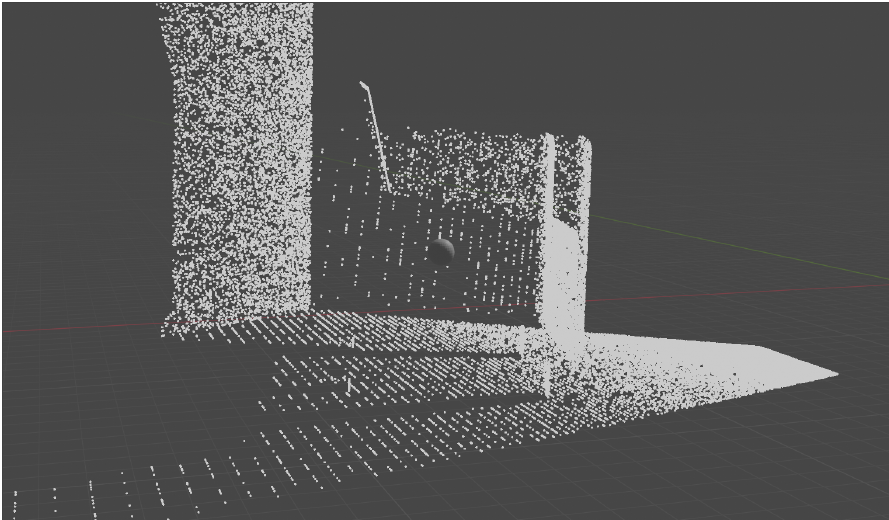
Figure 11. Figure showing centre point of a detected object with real